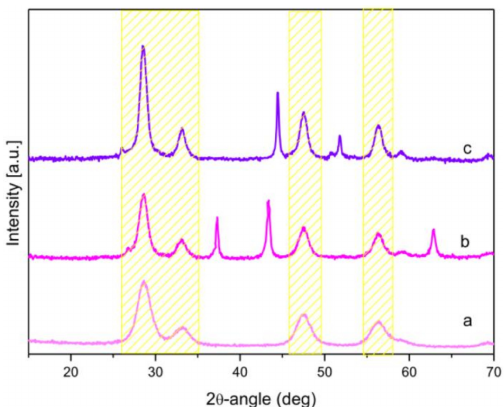
Figure 1. X-ray patterns of: gadolinium-doped ceria (GDC) support (spectrum a)—NiMoCu/GDC sample after calcination (spectrum b), and after reduction (spectrum c). Features arising from the GDC support are